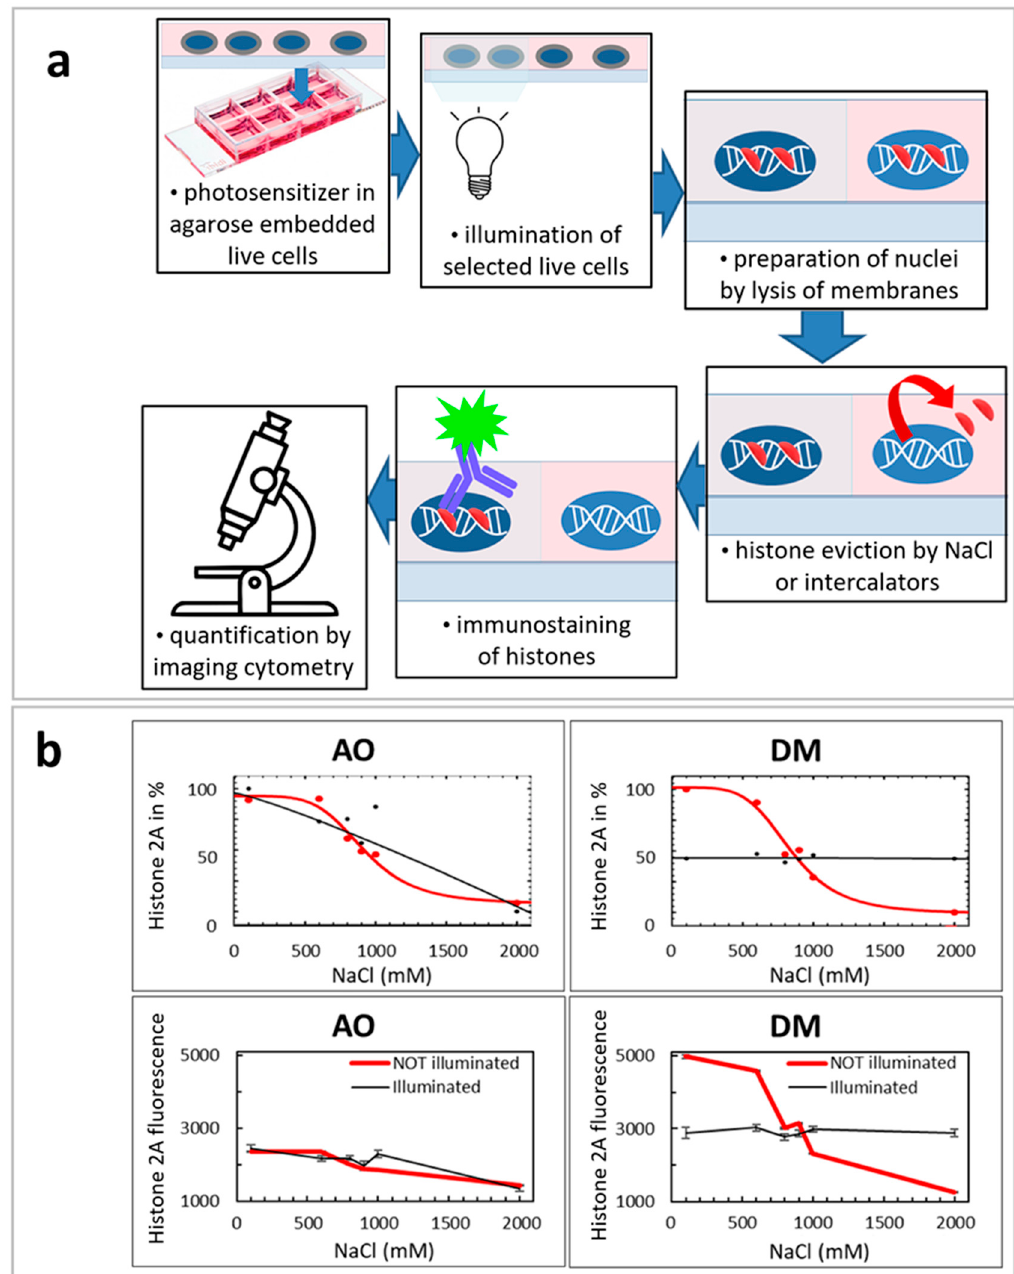
Figure 6. Loss of histone H2A and photofixation in the chromatin. AO evicted more histone H2A from nuclei as a result of the light-induced nuclear DNA fragmentation. DM crosslinked more histone H2A to the chromatin in the illuminated HeLa cells. ( a ) Scheme of the modified QUINESIn method to detect chromatin integrity [24]. Histones are released from nuclei by applying high concentrations of salts unless the photo-treatment crosslinked proteins covalently to the DNA or other proteins. Anti-histone H2A antibodies were used to detect the presence of specific histones. ( b ) The amount of histone H2A was plotted versus the salt concentration. In the upper panels, the relative amount of histone H2A is given in percentages normalized to the no salt condition (100%). In the lower panels, raw data of the histone fluorescence are plotted on the ordinate in arbitrary units (mean ± SEM). The left panels show AO, while the right panels show DM sensitization. All black lines display the light treatment, while red curves label the absence of illumination. In this figure, we demonstrated one representative data set from three experiments.